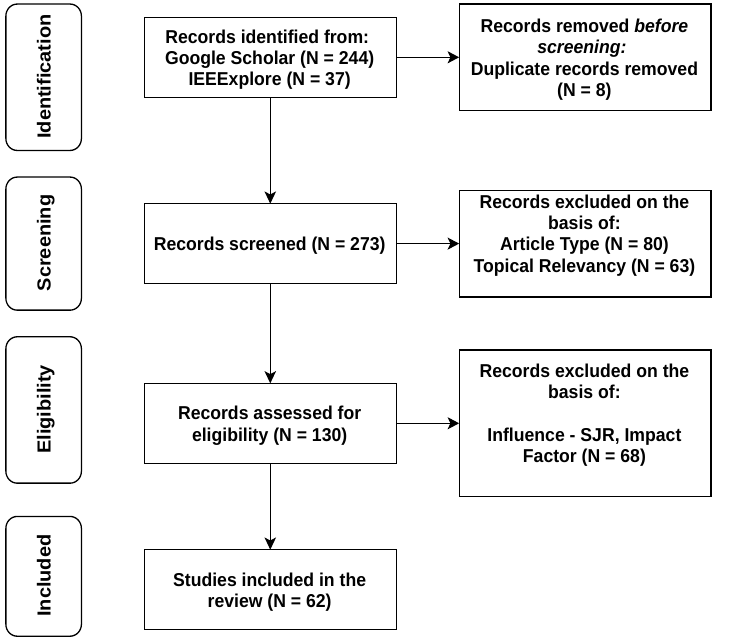
Figure 1. Summary of PRISMA flowchart of the article selection process for this